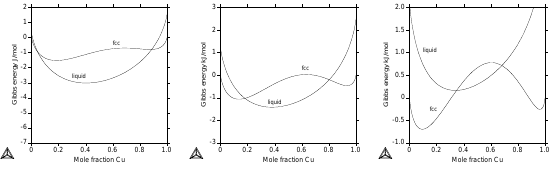
The diagrams below show the modelled Gibbs energy functions for two phases in a binary system at 3 different temperatures.